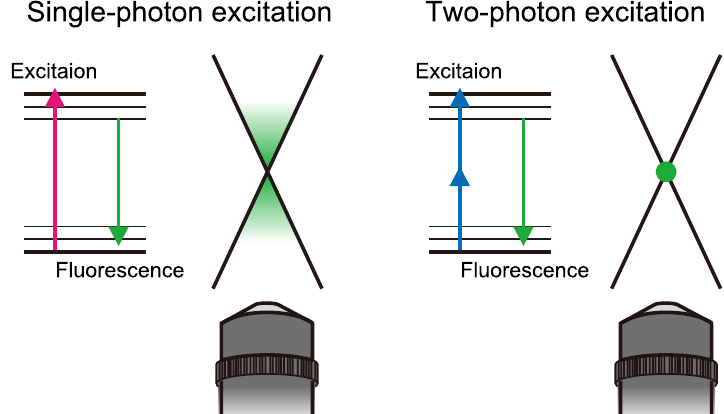
Fig. 1 Properties of two-photon excitation microscopy (2PEM). In conventional single-photon fluorescence microscopy, fluorescence molecules along the light path are excited. In 2PEM, two photons must reach the single fluorophore almost simultaneously, which occurs only at the focal plane, markedly reducing the background